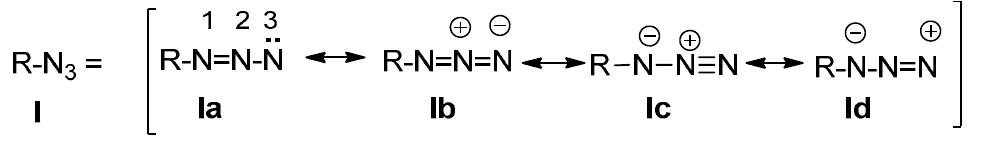
Figure 1. Mesomeric structures of organic azides.